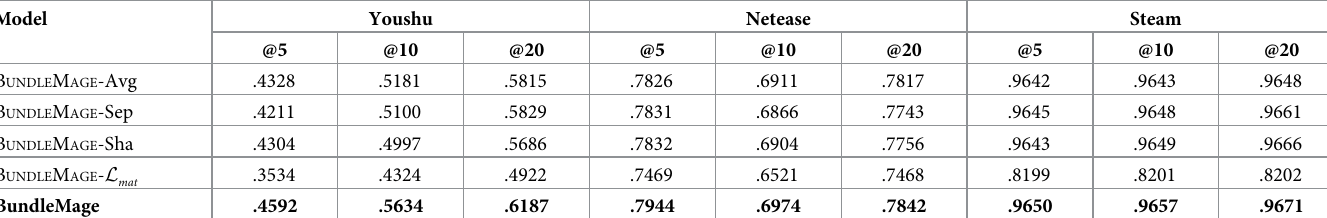
Table 6. Evaluation of BundleMage and its variants for bundle generation with respect to nDCG.